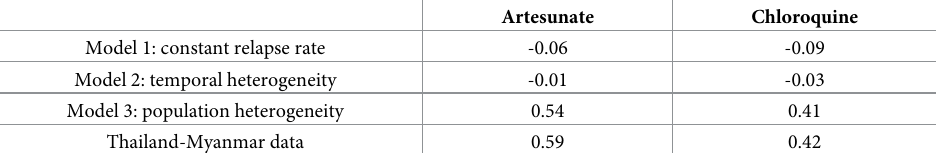
Table 1. Spearman correlation between time to first recurrence and time from first to second recurrence in the simulated data and the Thailand-Myanmar data excluding censored data. All 1,000,000 simulated individuals who had at least two recurrences during the 1-year-simulation were used to compute the Spearman correlation. Note that the very weak negative correlation for models 1 and 2 is most likely due the censoring in the simulated data after 1 year of follow-up (see Table L in S1 Tables for details). All p-values are below 0.0001 due to the large number of simulations. For the Thailand-Myanmar data, we show here the Spearman correlation for artesunate or chloroquine treated individ- uals, excluding censored individuals (for the correlations of all individuals including censored data see Table K in S1